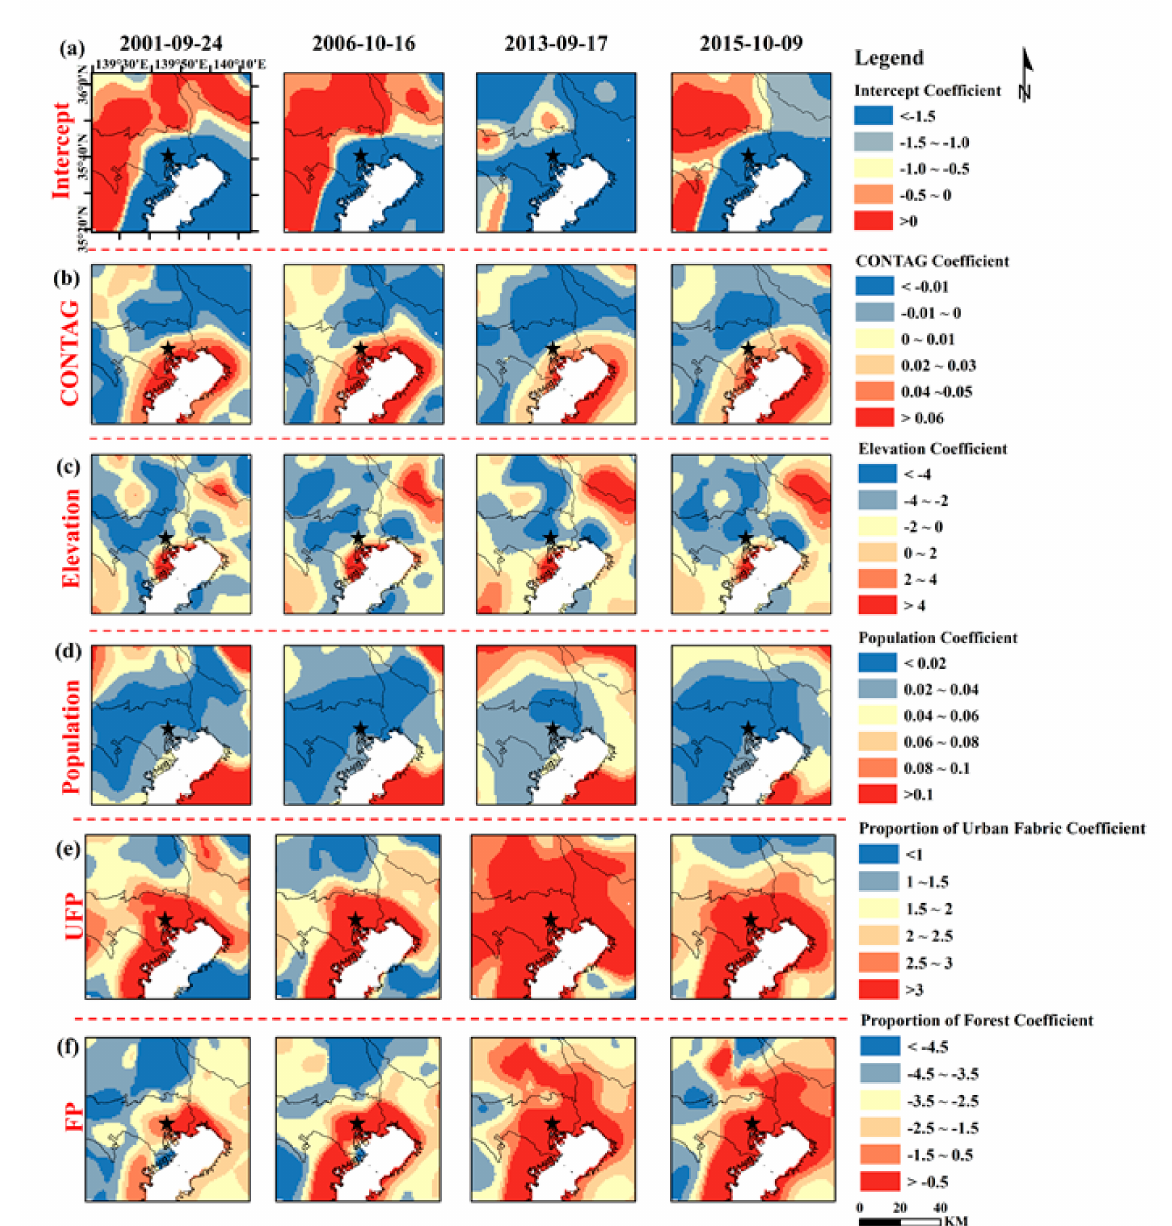
Figure 9. Spatiotemporal variations of estimated local coefficients derived from GWR models: ( a ) intercept, ( b ) CONTAG, ( c ) elevation, ( d ) population coefficient, ( e ) proportion of urban fabric, and ( f ) proportion of